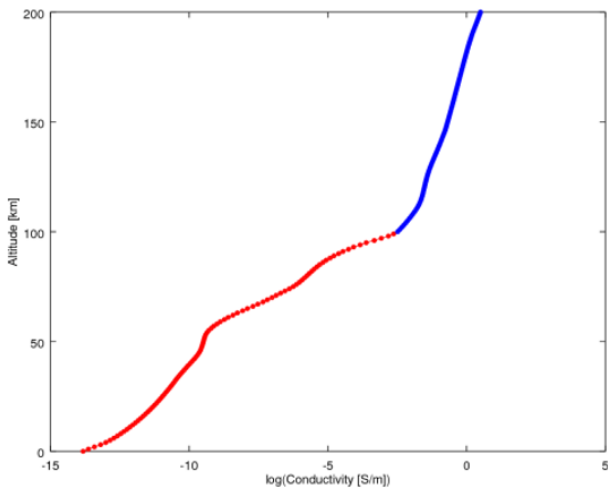
Figure 2. A realistic conductivity profile up to 200km obtained by combining the profile from Kudintseva et al. (2016) (red part) and an IRI profile (blue